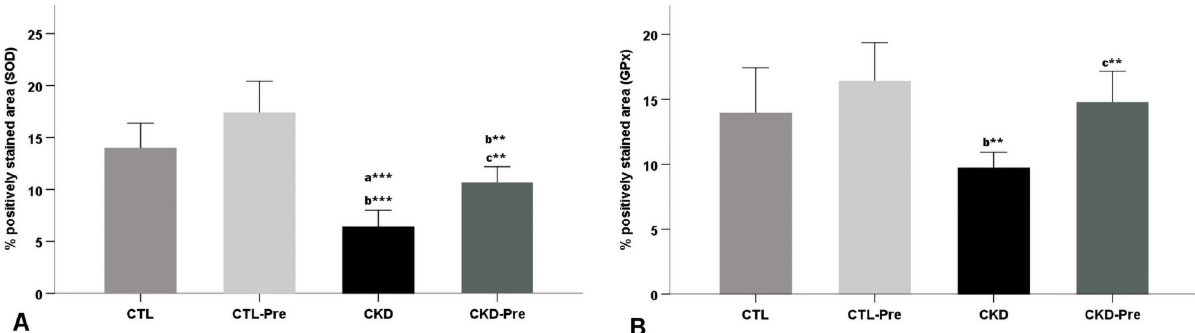
Fig 2. Bars represent the quantitative analysis of (A) SOD positively stained area (%) and (B) GPx positively stained area (%). Data are expressed as mean ± SEM. “a” significant difference compared to CTL group; “b” significant difference compared to CTL-Pre group; “c” significant difference compared to CKD group. � p < 0.05; �� p < 0.01; ��� p <